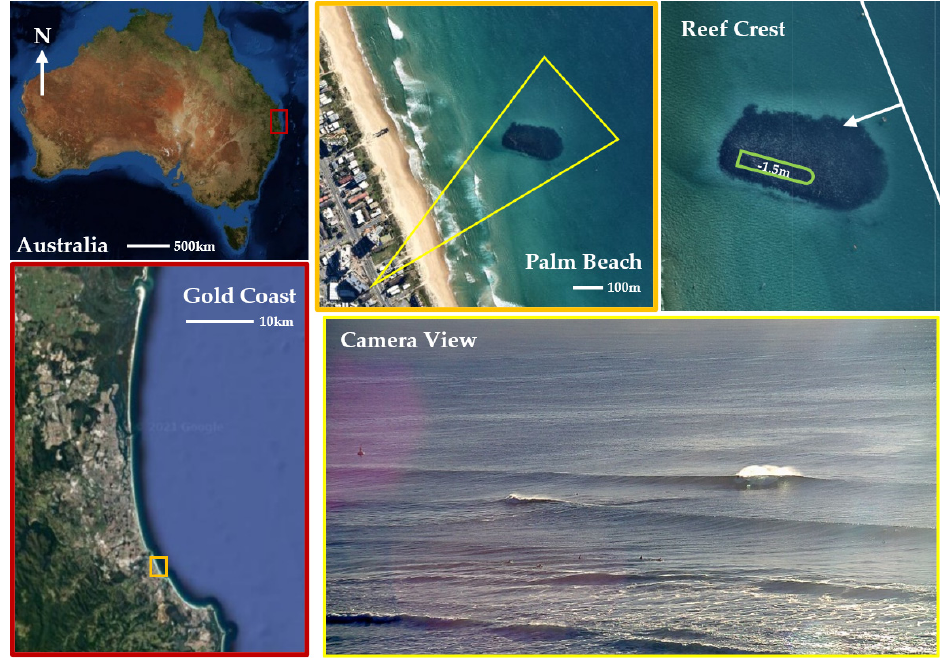
Figure 5. Location of field site. The reef crest is shown in green and camera view is outlined in yellow (snapshot taken from 16 July 2020). White arrow in top right shows prevailing wave direction of 70°.